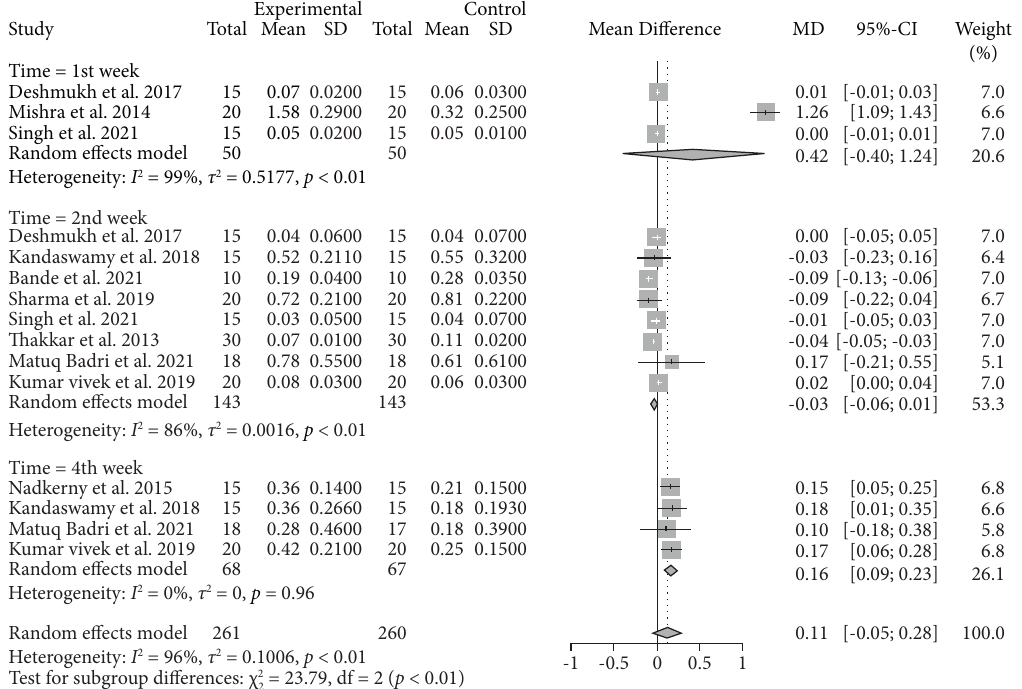
Figure 5: Forest plot for the plaque index (experimental: probiotics and control: chlorhexidine).